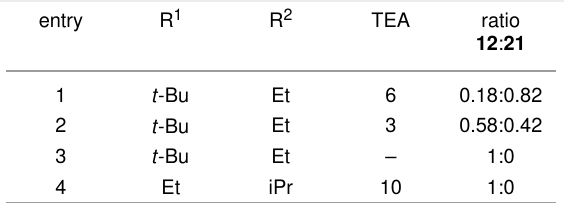
Table 2: Investigation of the reaction between compound 12 , phospho- noacetates 8 and BTMS.